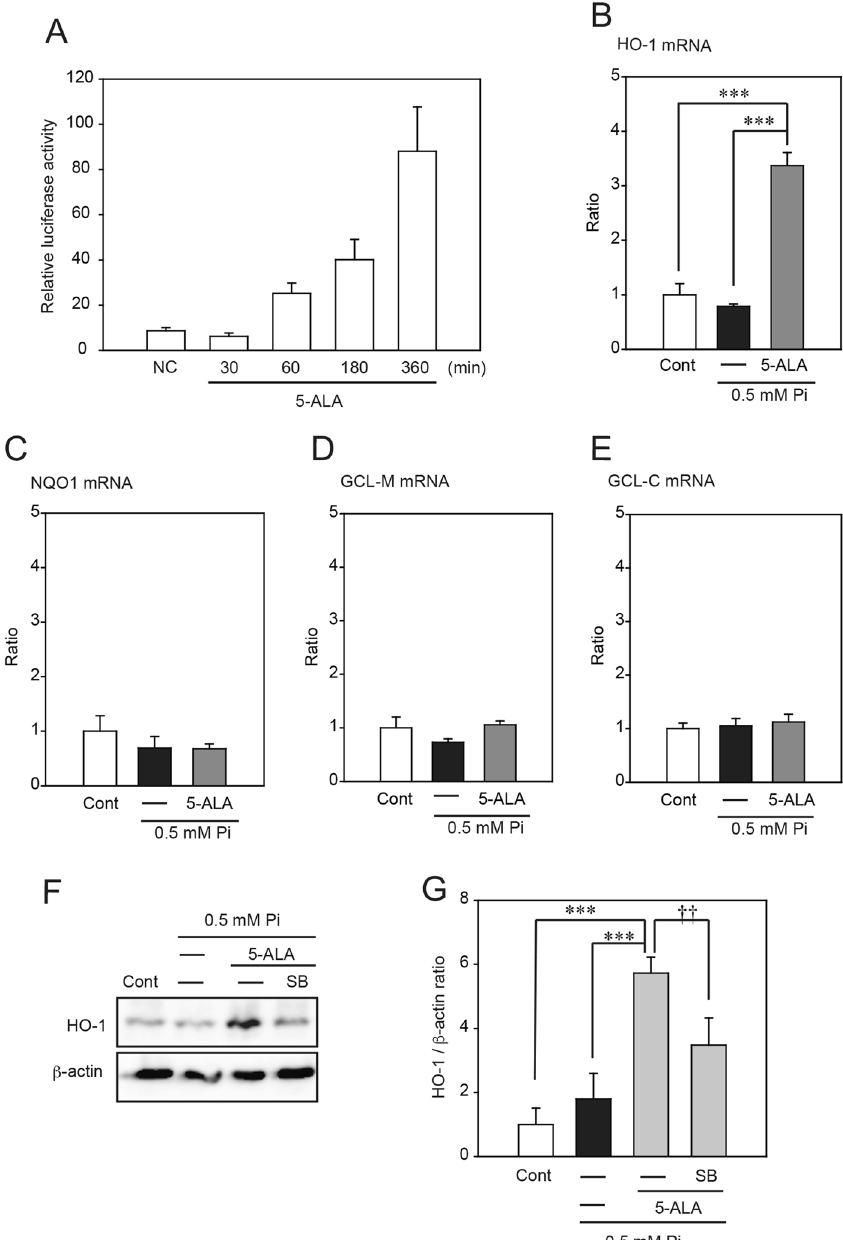
Figure 6. The p38 MAPK signaling pathway is involved in the increased expression of HO-1 induced by 5-ALA. ( A ) The ARE reporter assay. ( B – E ) qRT-PCR analysis of the effects of 5-ALA on the mRNA expression level of HO-1 ( B ), NQO1 ( C ), GCLM ( D ), and GCLC ( E ). ( F , G ) Western blot analysis showing the effect of the p38 MAPK inhibitor SB203580 (SB) on 5-ALA-induced expression of HO-1. Each value represents the mean ± SEM of three determinations, based on the untreated culture (control). The significance of any difference was determined using ANOVA, followed by the Bonferroni/Dunn post-hoc test ( * p < 0.05 versus control; † p < 0.05, †† p < 0.01 versus treatment with 0.5 mM